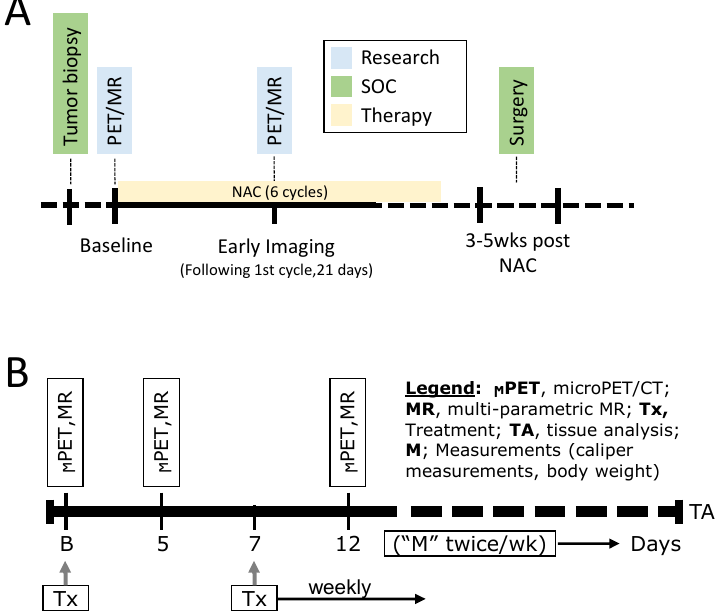
Figure 8. ( A ) Clinical imaging protocol and ( B ) preclinical imaging protocol to assess response to carboplatin/docetaxel therapy in TNBC.